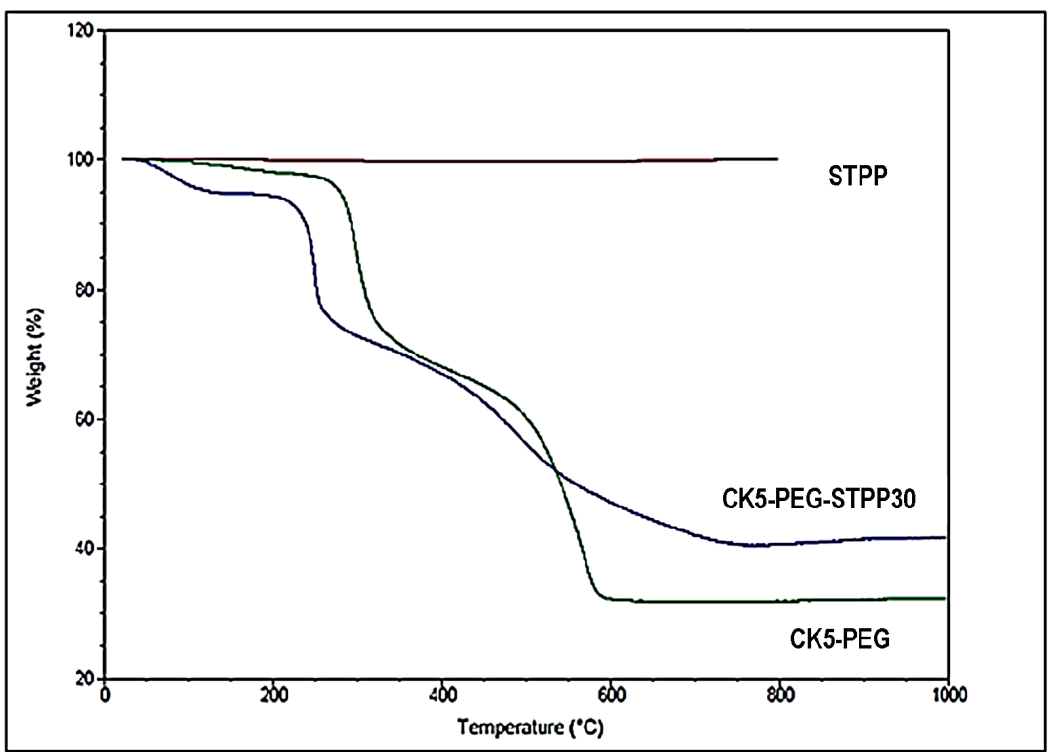
Figure 7. Thermograms of STPP powder, non-cross-linked CK5-PEG and 30-minute cross-linked CK5-PEG-STPP30 composite membranes.